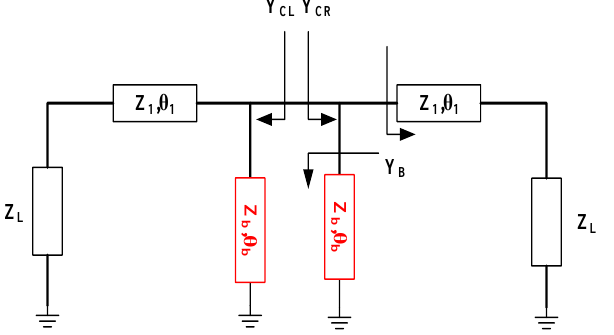
Figure 4. The impedance transformation relation of the proposed bias circuit.